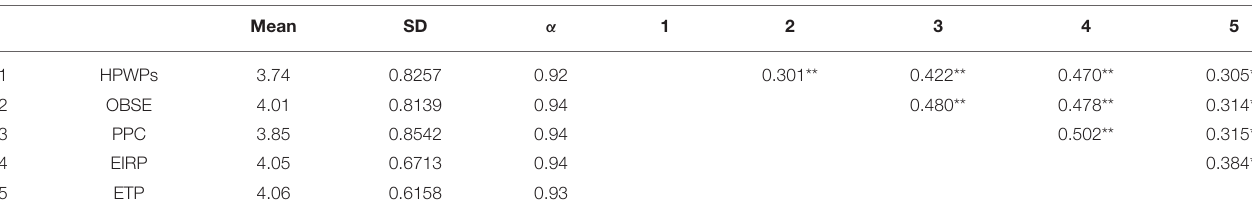
TABLE 1 | Correlations, descriptive, and reliability